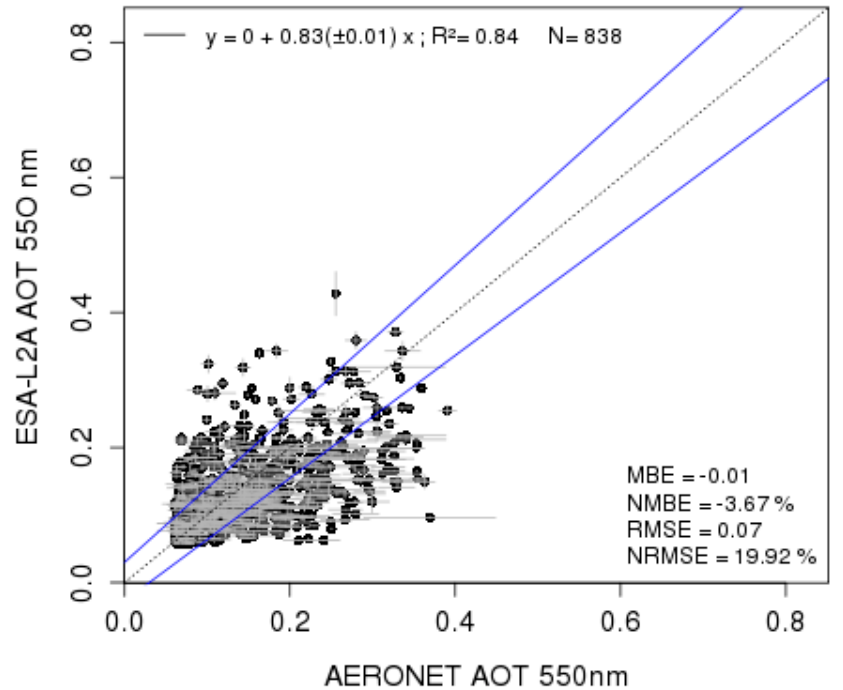
Figure 6. Scatter plot of AOT from ESA-L2A retrievals versus coincident AERONET Level 2.0 data for the sub-period after 15 January, 2018 excluding data corresponding to AERONET AOT lower than 0.06 and to stations with a percentage of cases of AOT = 0.2 higher than 20%. The dashed grey line indicates the x = y line and the solid blue lines show the accuracy requirement limits (a) | ∆ AOT 550 | ≤ 0.1 × AOT 550 ref + 0.03, and (b) | ∆ IWV | ≤ 0.1 × IWV ref + 0.2 [21].